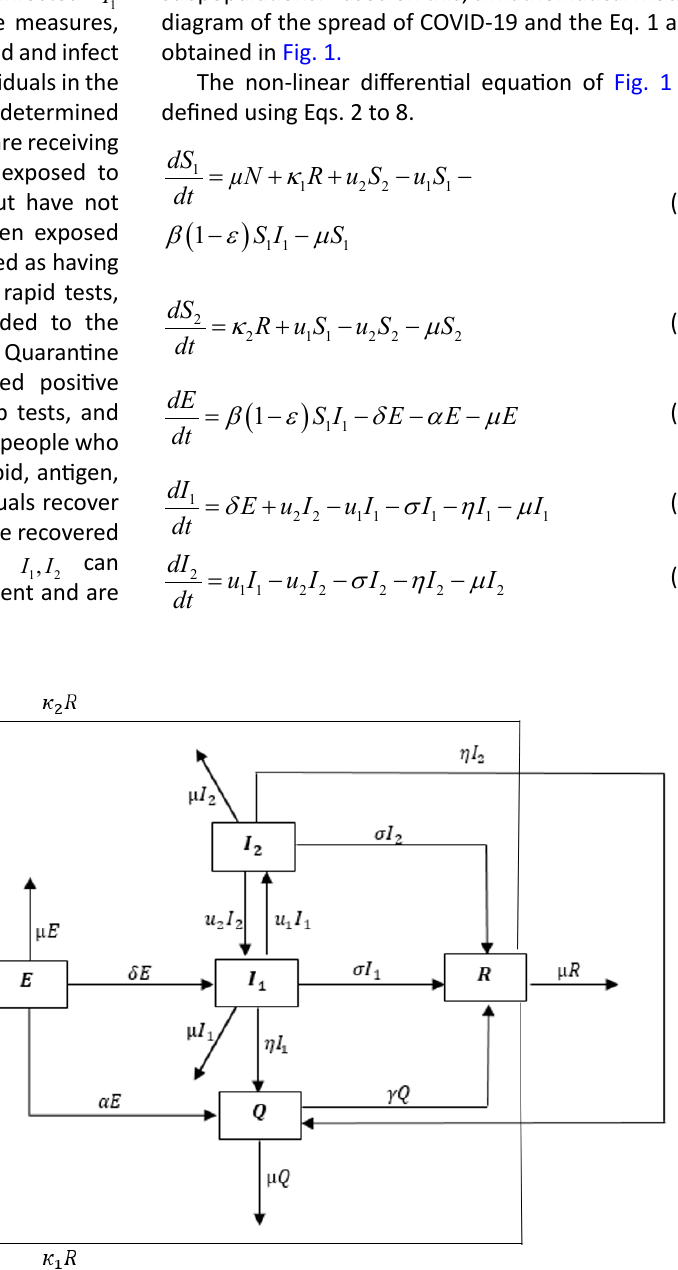
Fig. 1 : Diagram of the process of spreading COVID-19 with the use of masks and physical distancing